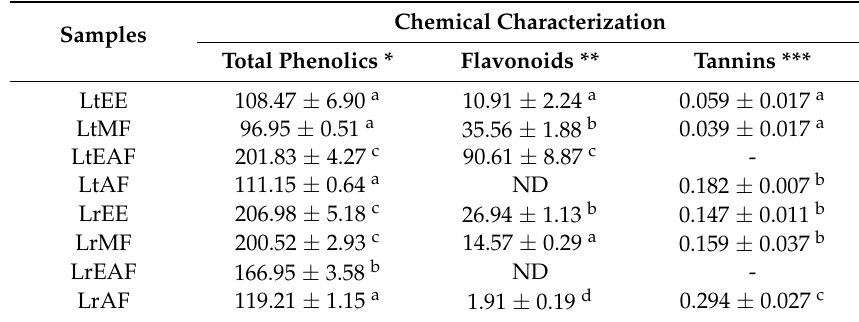
Table 2. Total phenolics, flavonoid and tannin content of Licania tomentosa and L. rigida seed extracts.